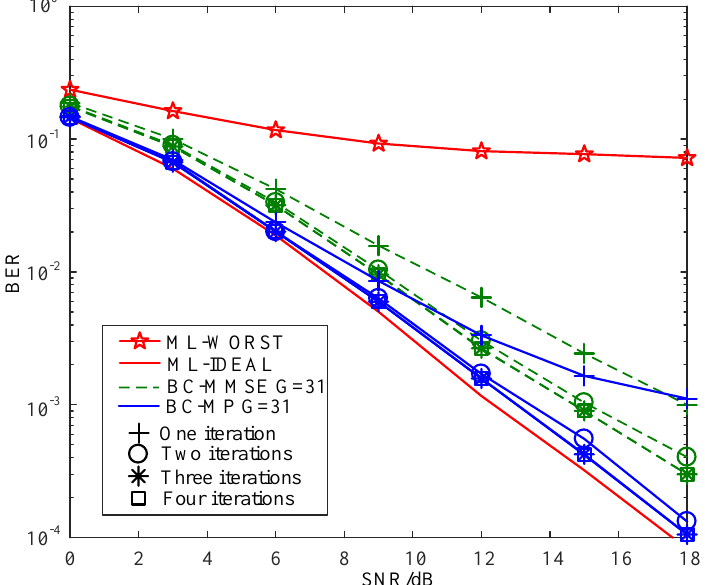
Figure 4. BER comparisons of the proposed BC-MMSE and BC-MP detectors for the GSTFIM systems with N t = 2 and N r =